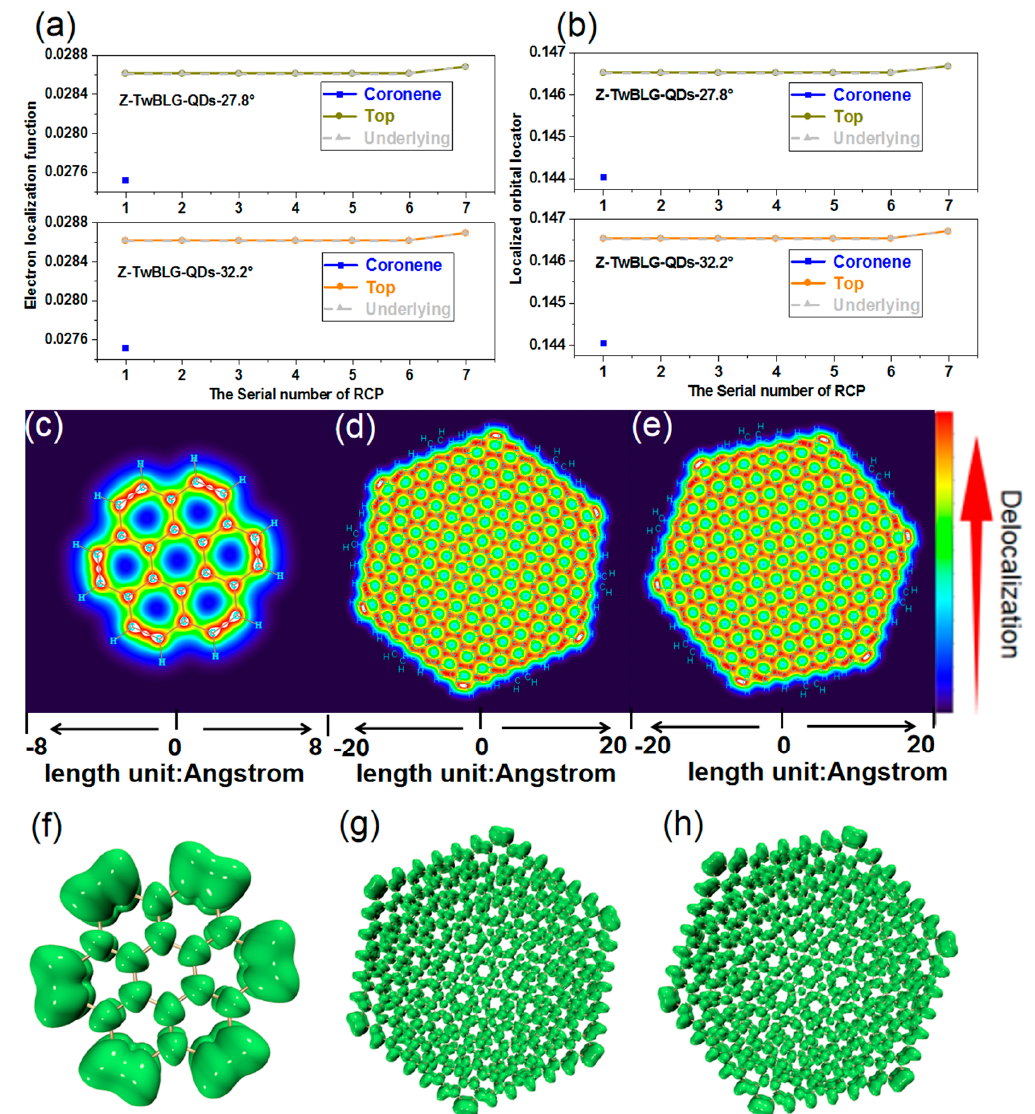
Figure 7. The theoretical calculation of LOL and ELF of RCP in Z-TwBLG-QDs-27.8° and Z-TwBLG-QDs-32.2° in the Moiré superlattice ( a , b ). LOL_pi color-filled map of Coronene, Z-TwBLG-QDs-27.8° and Z-TwBLG-QDs-32.2° ( c – e ). The ELF_pi isosurface of Coronene, Z-TwBLG-QDs-27.8°, and Z-TwBLG-QDs-32.2° ( f – h ); the isovalue is 0.7.